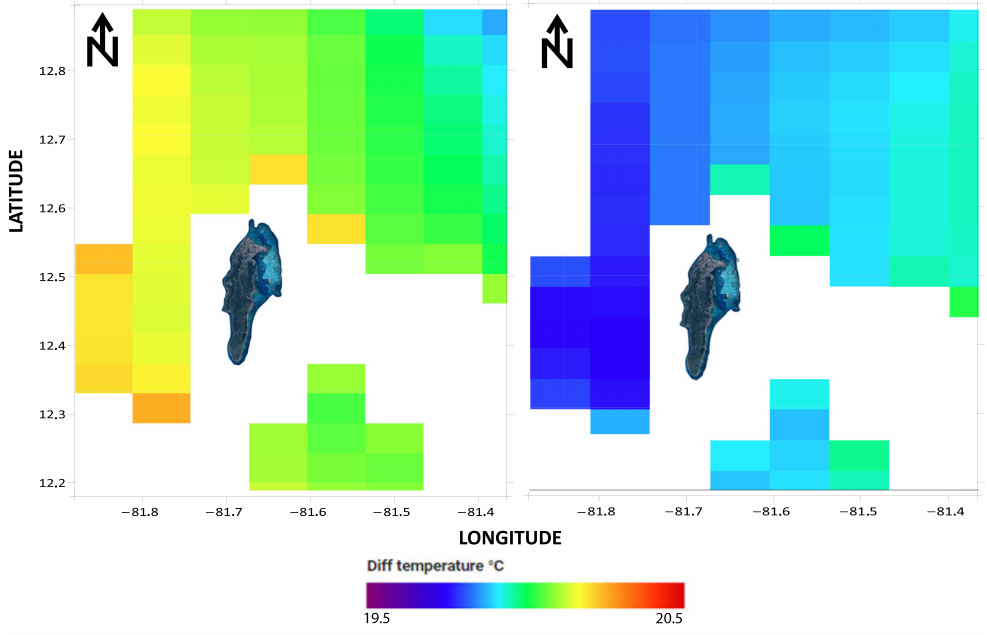
Figure 1. Differential on water temperature between surface and 1000 m depth around San Andrés Island on March (left ) and September ( right